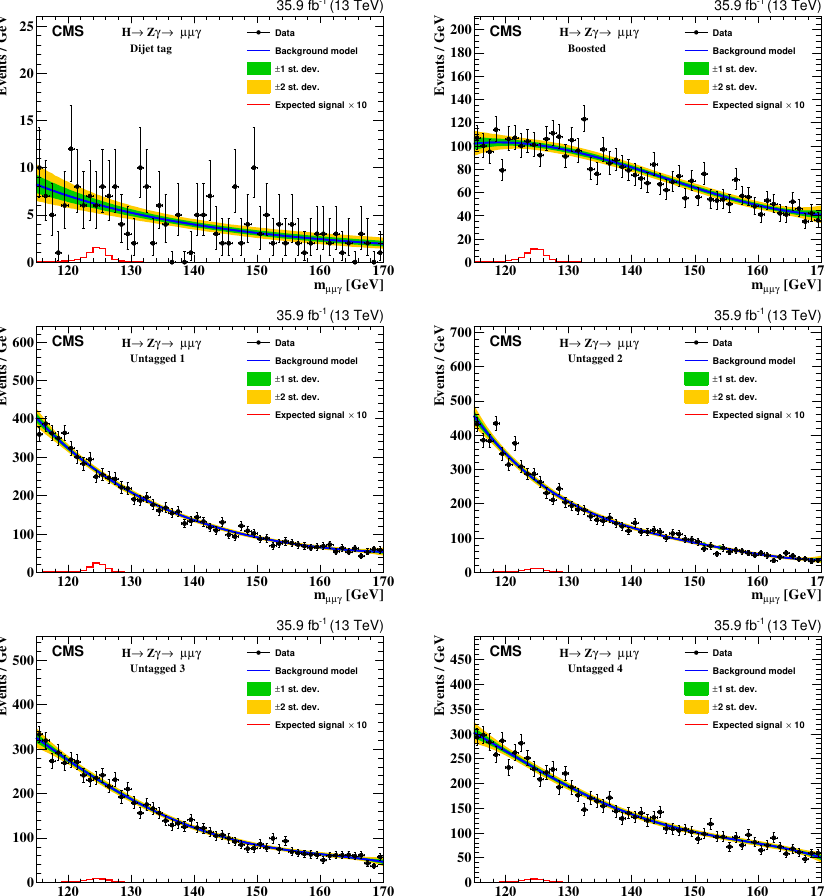
Figure 4 . Background model (cid:12)t to the m (cid:22)(cid:22)(cid:13) distribution for dijet tag (upper left), boosted (upper right), untagged 1 (middle left), untagged 2 (middle right), untagged 3 (bottom left), and untagged 4 (bottom right) for the H Z (cid:13) (cid:22)(cid:22)(cid:13) selection. The green and yellow bands represent the 68 ! ! and 95% CL uncertainties in the (cid:12)t to the data.